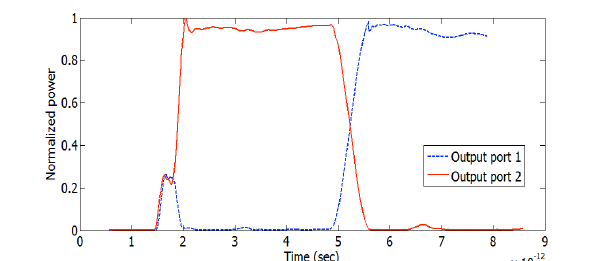
Figure 9: FDTD results of the PhC directional coupler to show its time-domain switching